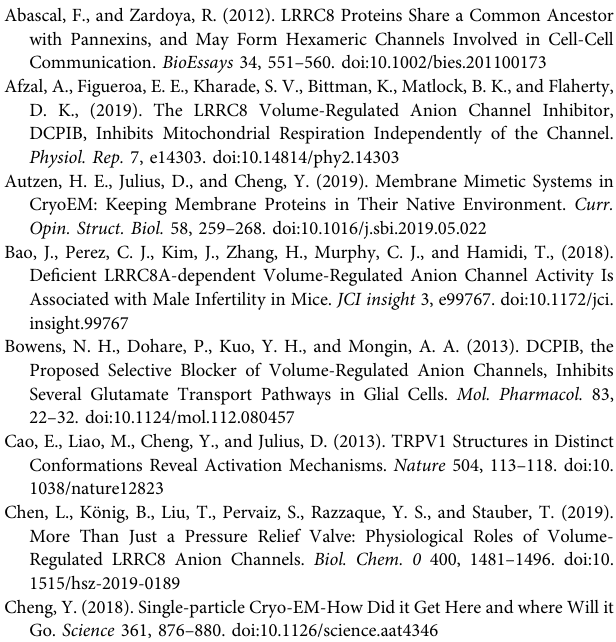
Figueroa, E. E., and Denton, J. S. (2022). A SWELL Time to Develop the Molecular Pharmacology of the Volume-Regulated Anion Channel (VRAC).